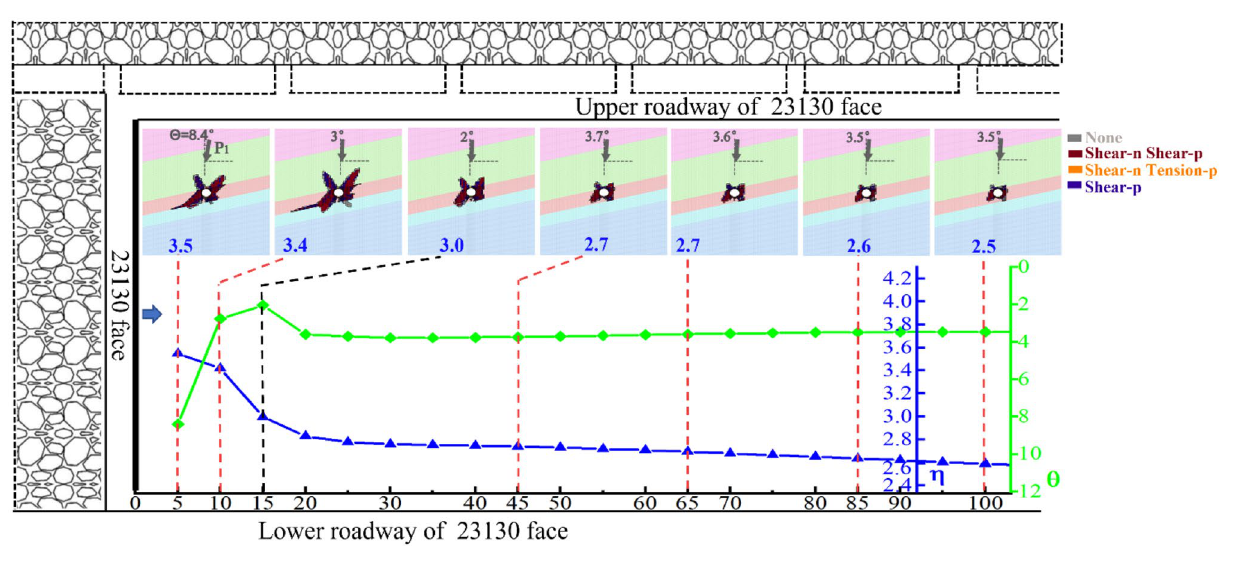
Fig. 7 Change of morphological characteristics of plastic zone with working face distance